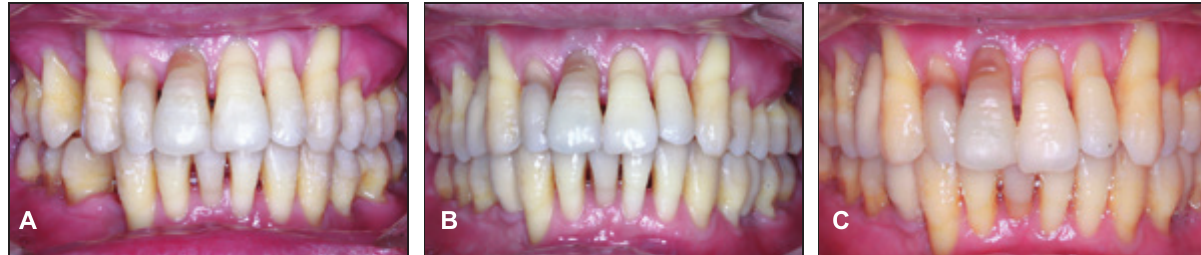
Figure 12. Change in the height of gingival attachment of the upper left incisor; A. Pretreatment B. Post-treatment